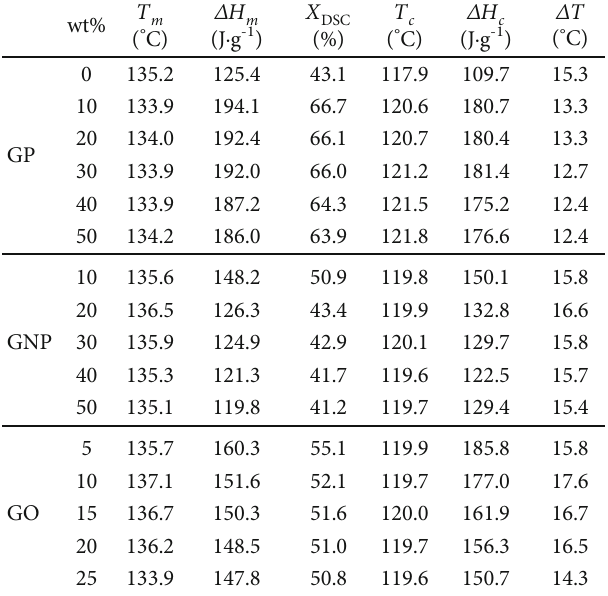
Table 2: The DSC data of UHMWPE composites.